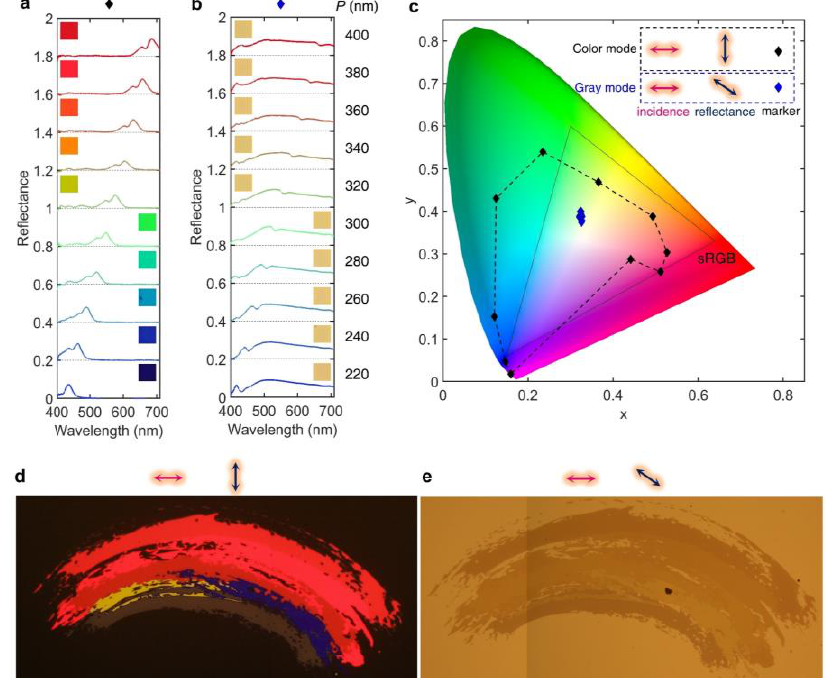
Figure 3. The color performance of fabricated embedded chiral metasurface under different observation conditions. ( a ) Reflectance spectra and micrographs of the embedded chiral metasurface under cross-polarization observation conditions (0 degree incidence, 90 degree reflectance). ( b ) Reflectance spectra and micrographs of the embedded chiral metasurface under observation conditions of 0 degree incidence and 135 degree reflectance. ( c ) The corresponding CIE 1931 chromaticity diagram of ( a , b ). Rainbow images in ( d ) color mode and ( e ) gray mode.